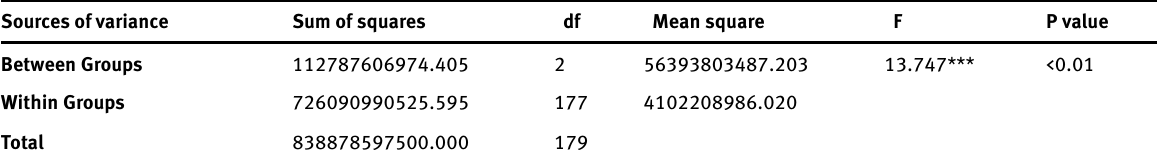
Table 7: ANOVA result for differences in profits earned by rice farmers in different production systems Sources of variance Sum of squares df Between Groups